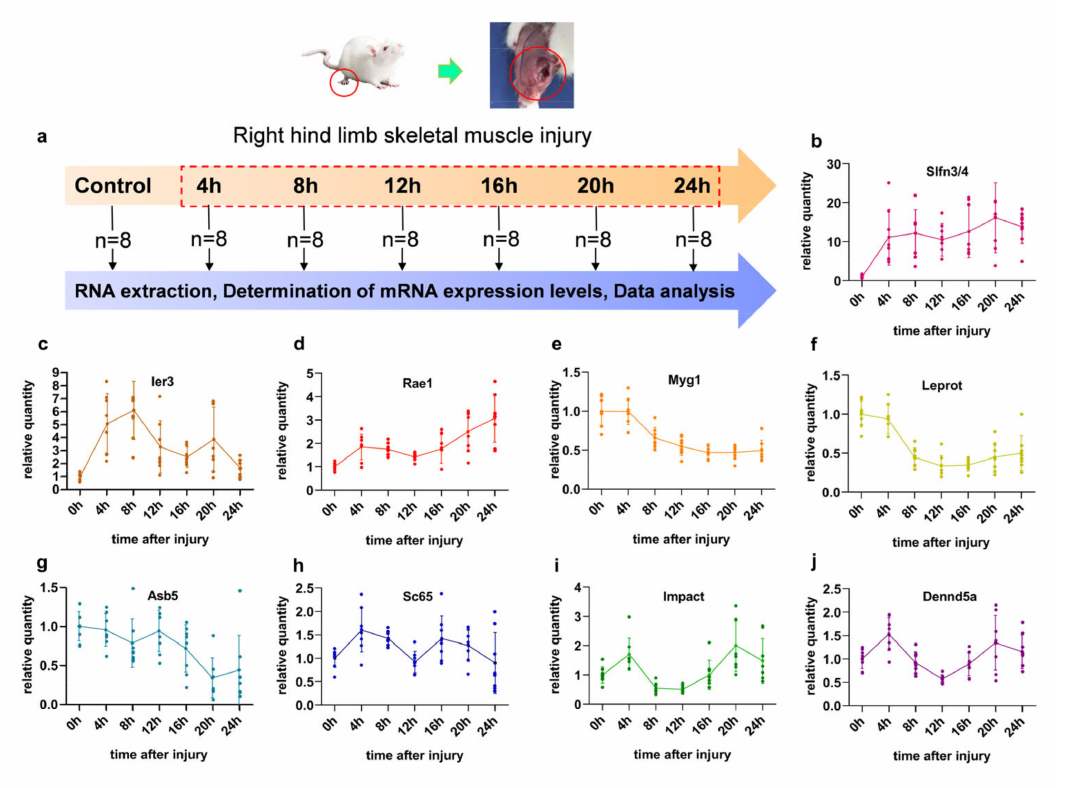
Figure 2. Sampling of skeletal muscle contusion of rats and detection of gene expression profiles. ( a ) The contused skeletal muscle was collected from rats at different time points after injury. ( b – j ) The expression profiles of nine mRNAs. Each dot represents a sample. The 0 h in the graph represents the control